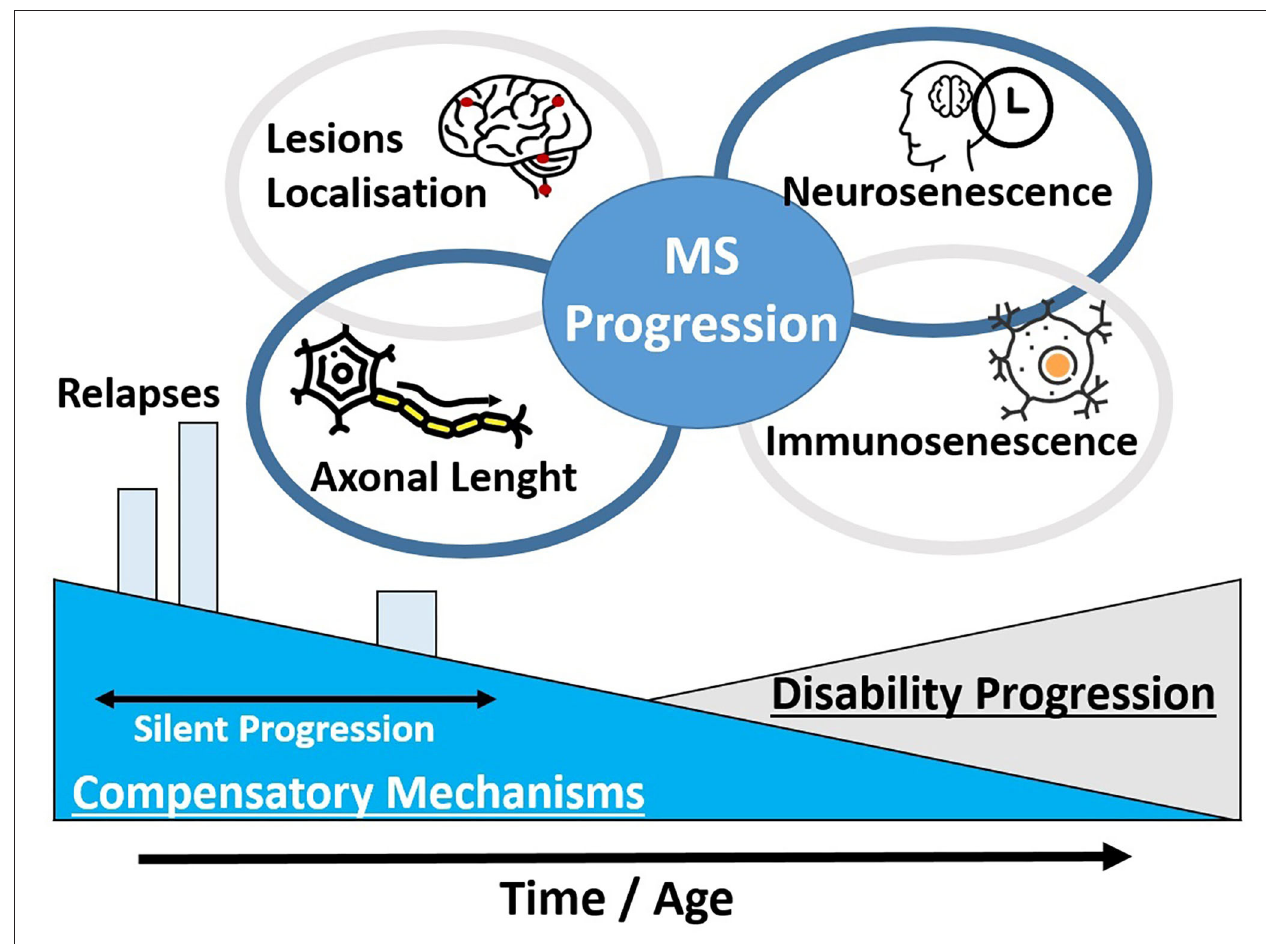
FIGURE 1 | Certain pathophysiological theories for the clinical disability progression in MS patients are unified. The development of clinical disability may depend at a great part on the decrease of compensatory mechanisms and an advance in the patients’ age. In addition, the localization of MS lesions and the axonal length of these domains may explain the different clinical presentation among MS patients. A progressive neurosenescence and immunosenescence process may occur in a phase of silent